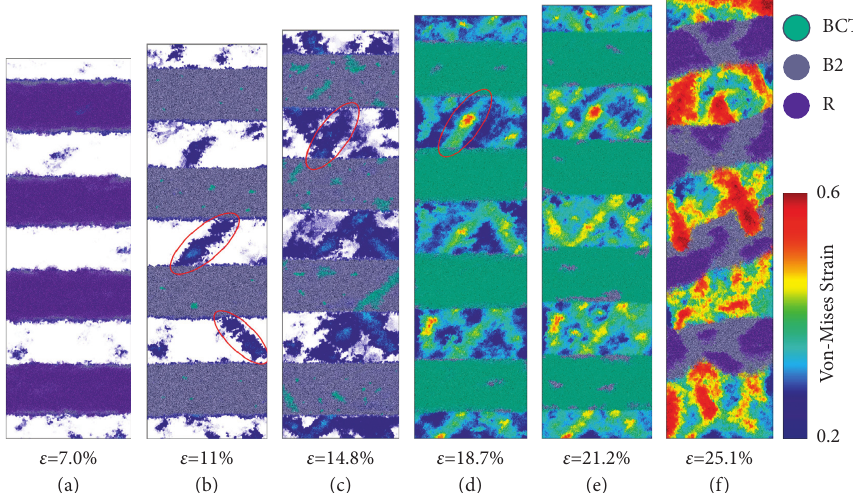
Figure 4: The atomic configurations of the composite fabricated by the Cu